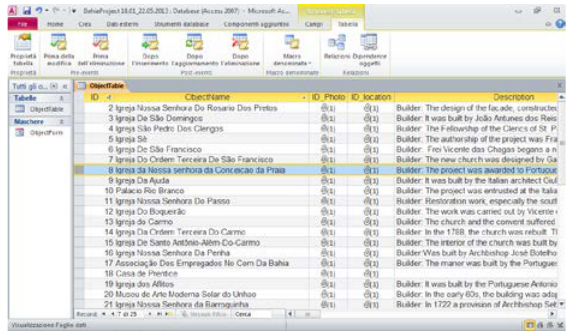
Figure 6. Some records of the Object Table